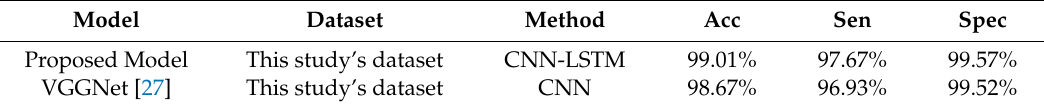
Table 7. Comparison of the proposed model with VGGNet.